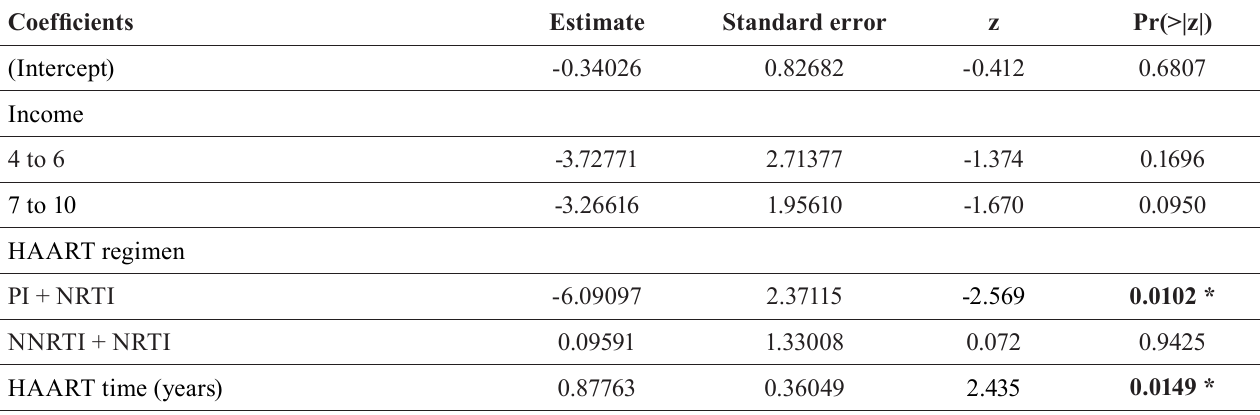
TABLE VII - Relationship between variables and adherence according to final CEAT-VIH